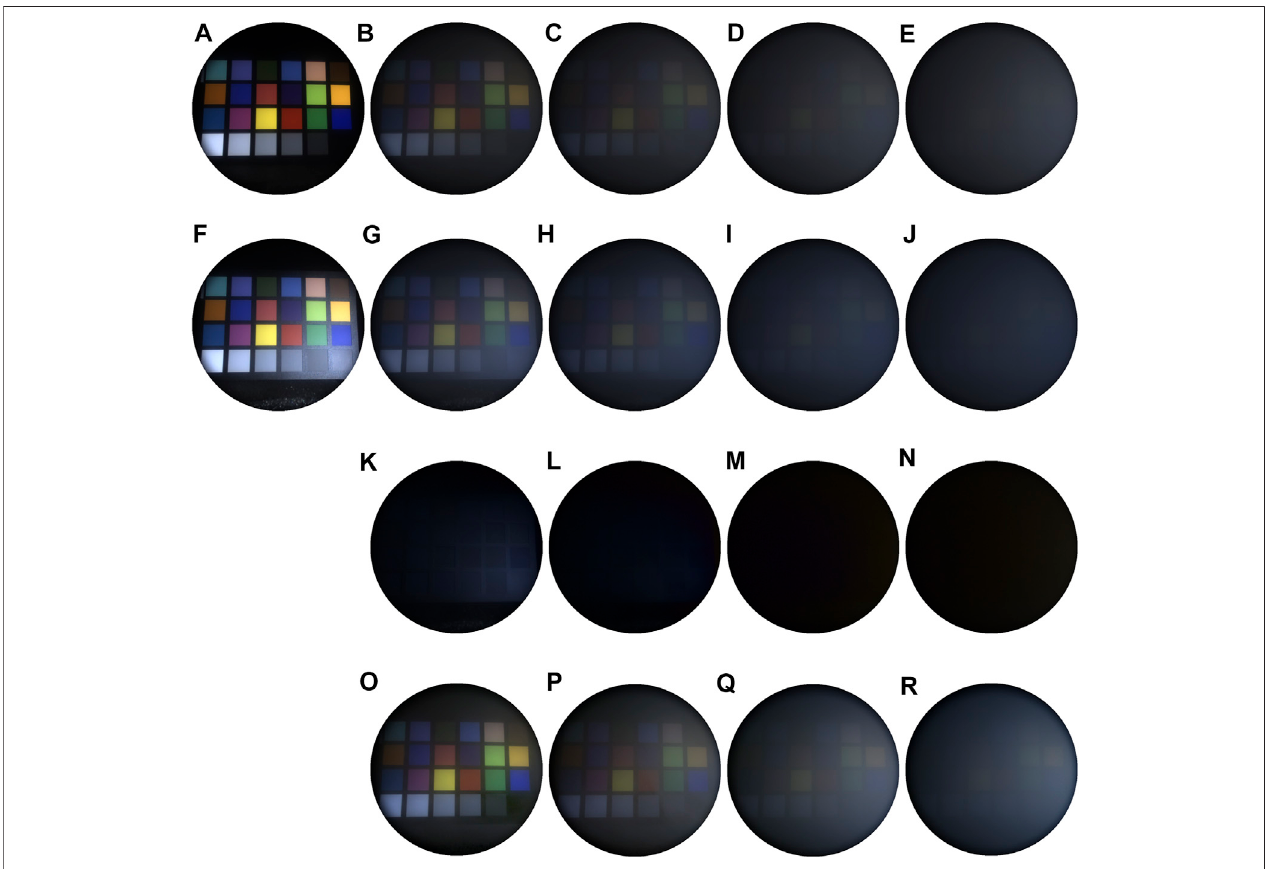
FIGURE10| Theresultsofcircularpolarimetricimaging:theintensityofrightcircularpolarized (A) andleftcircularpolarized (F) insmoke-freescenario,theintensity of right circular polarized (B – E) and left circular polarized (G – J) channels at four different concentrations, the corresponding polarization difference results (K – N) and visibility restoration results (O – R)